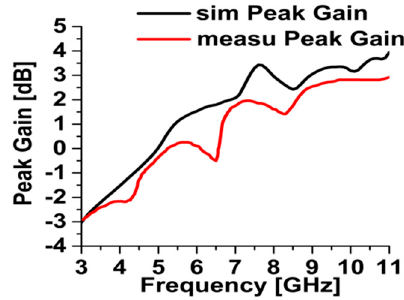
Figure 9. Simulated and measured peak gain.